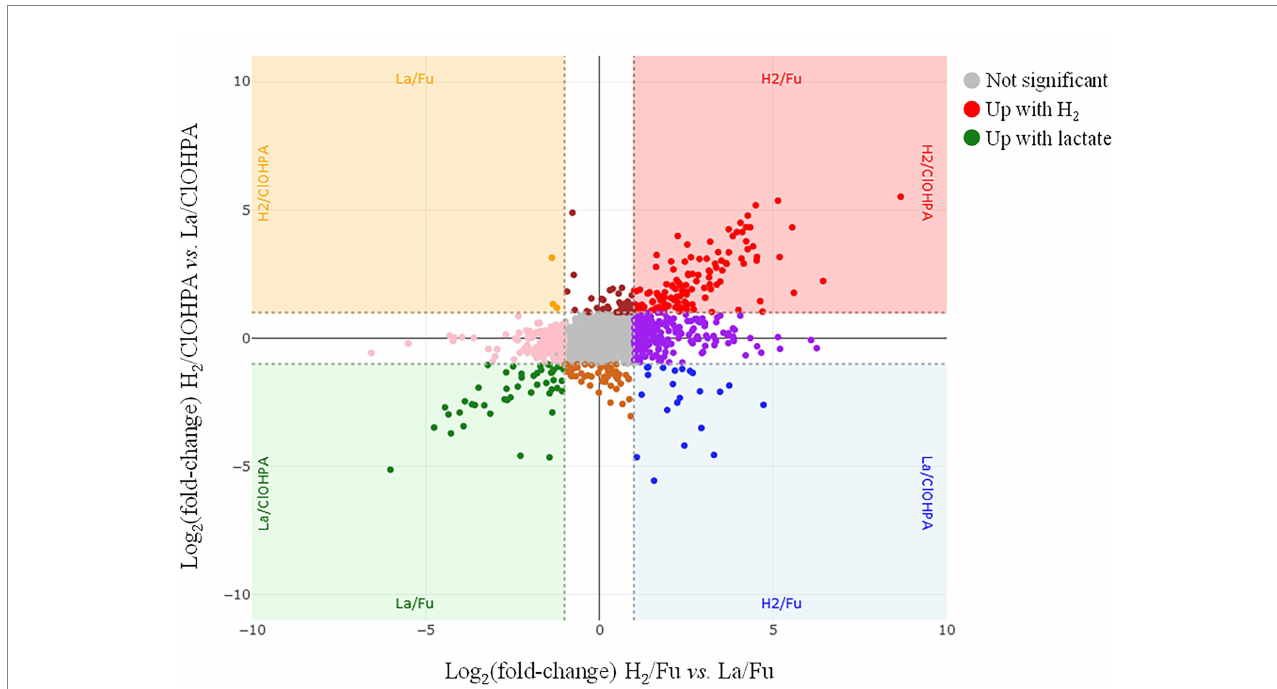
FIGURE 3 Scatter plot displaying the distribution of the proteins in the pairwise comparison of the proteomes from cells growing on H 2 /Fu vs. La/Fu and H 2 /ClOHPA vs. La/ClOHPA conditions. Note that the proteins significantly up-regulated in H 2 conditions are displayed in red in the upper right corner, while those induced by lactate are in green in the lower left corner of the scatter